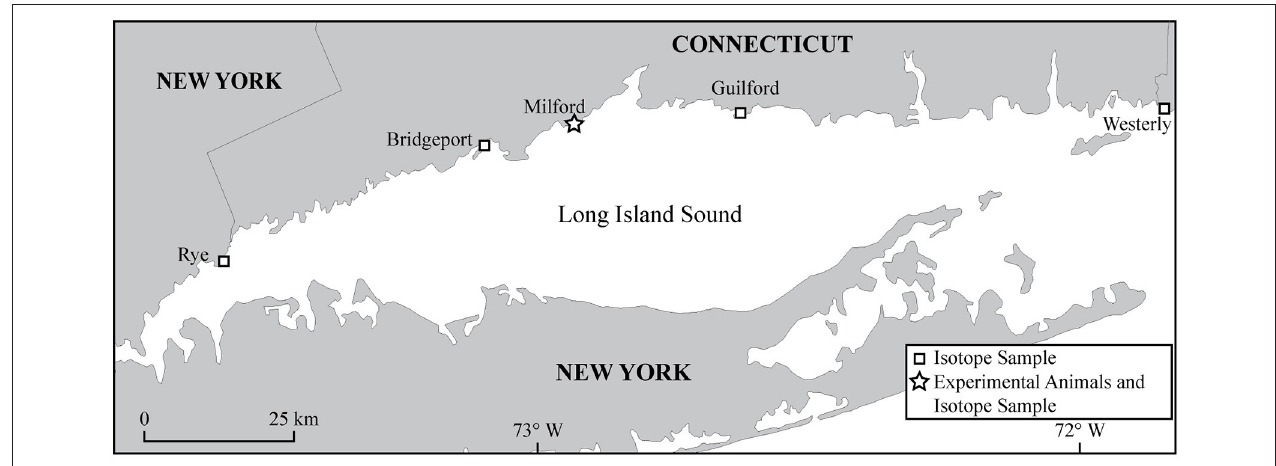
FIGURE 1 | Map of Long Island Sound. Symbols show sample locations of field-collected (from Casey et al., 2014) and experimental specimens.